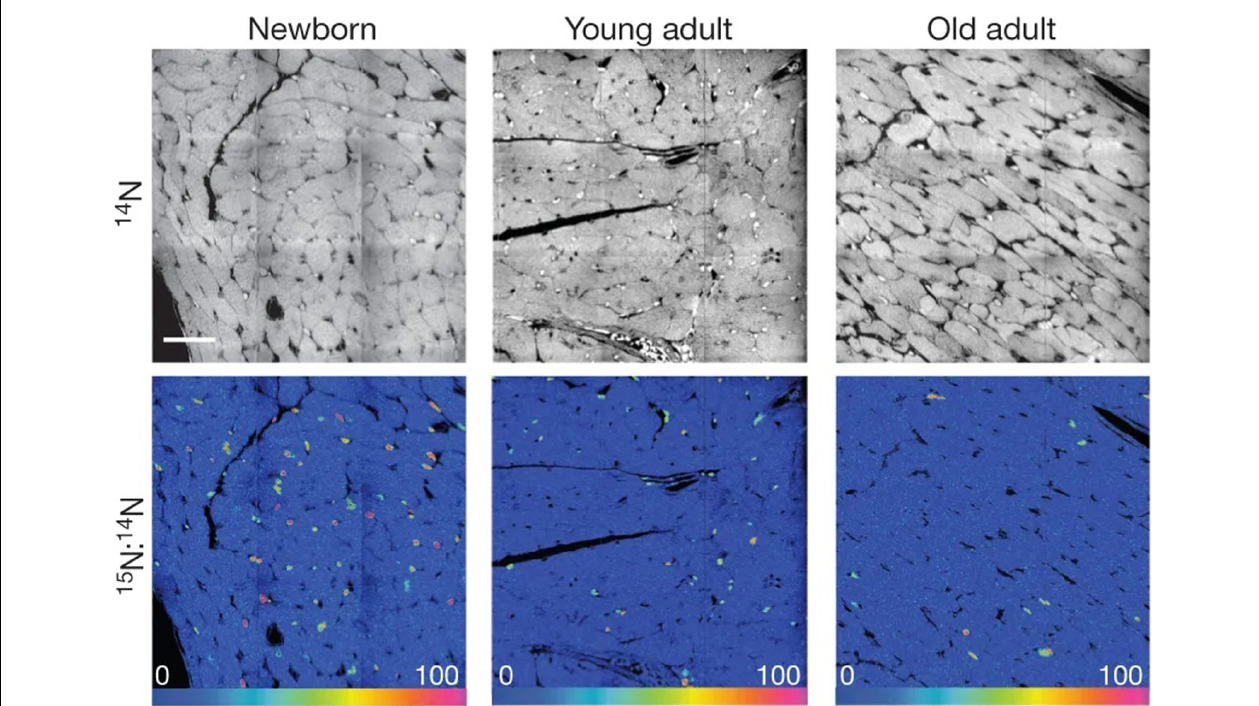
FIGURE 5 | [ 15 N]Thymidine was administered for 8weeks to mice of different ages: newborn, starting at postnatal day 4; young adult, starting at 2months; old adult, starting at 22months. Top, 14 N mass images show histological details. Bottom, 15 N: 14 N hue–saturation–intensity images show 15 N + nuclei. Mosaics are constructed from nine tiles, 60 µ m each. Scale bar: 30 µ m. These data indicate a decrease in 15 N-labeled cells with age, which demonstrates that DNA synthesis in cardiomyocytes decreases with age under normal conditions. In this case, the 15 N label acts to mark DNA synthesis occurring after the administration of the isotope label. Reprinted by permission from Senyo et al.